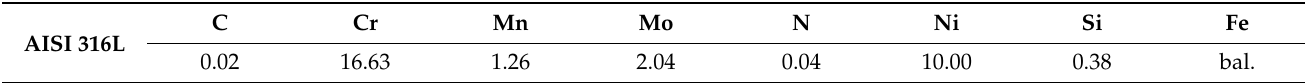
Table 2. Chemical Composition of AISI 316L